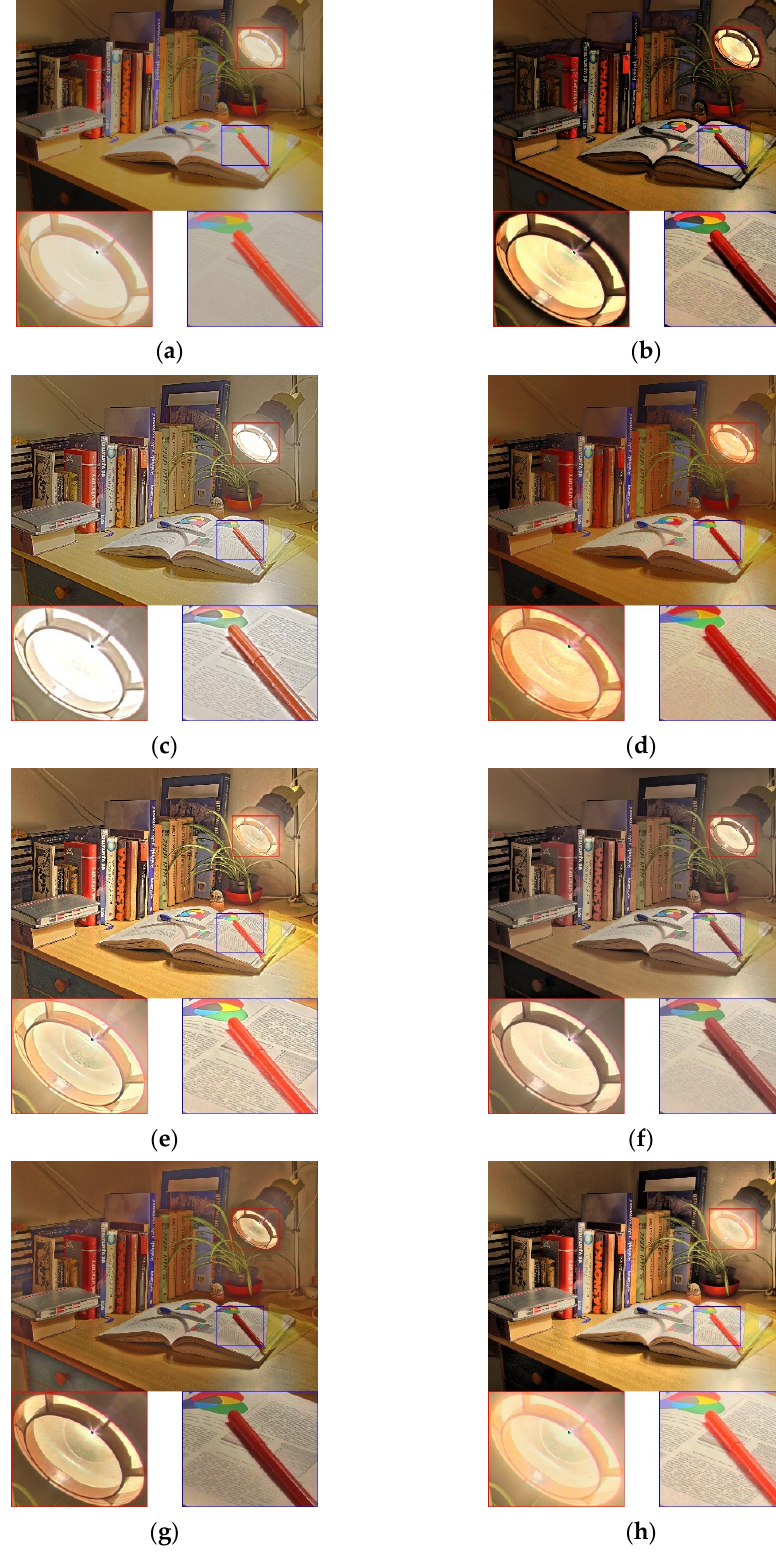
Figure 8. Visual comparison using the test image Cadik_Desk02. ( a ) Result of [4]. ( b ) Result of [9]. ( c ) Result of [13]. ( d ) Result of [25]. ( e ) Result of [14]. ( f ) Result of [17]. ( g ) Result of [18]. ( h ) Result of the proposed method.